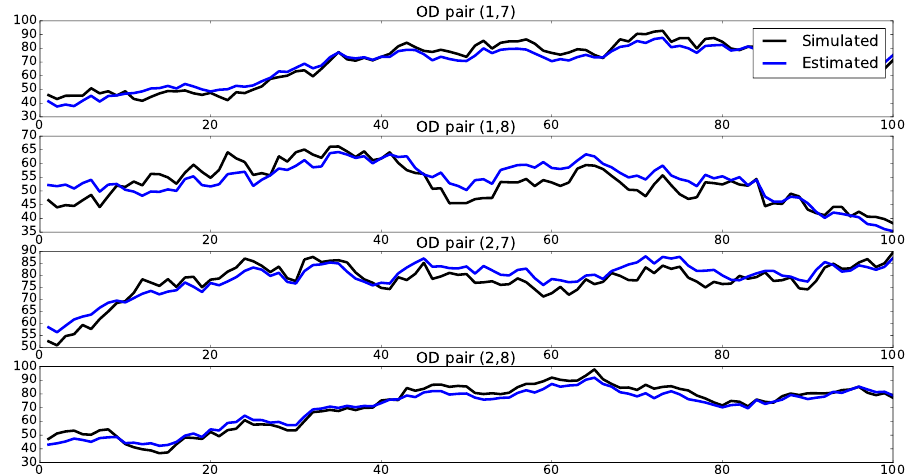
Figure 5. Simulated and estimated mean OD flows. Horizontal axes show time periods, while vertical axes show magnitude of OD